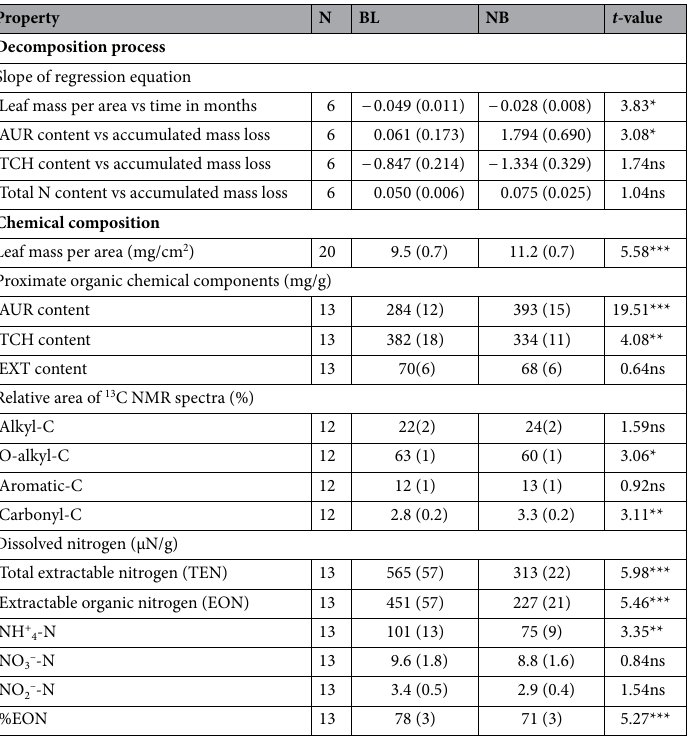
Table 2. Chemical properties and decomposition in bleached (BL) and nonbleached (NB) portions of leaf litter. N, number of tree species examined. Values are means with standard errors in parentheses. Paired t